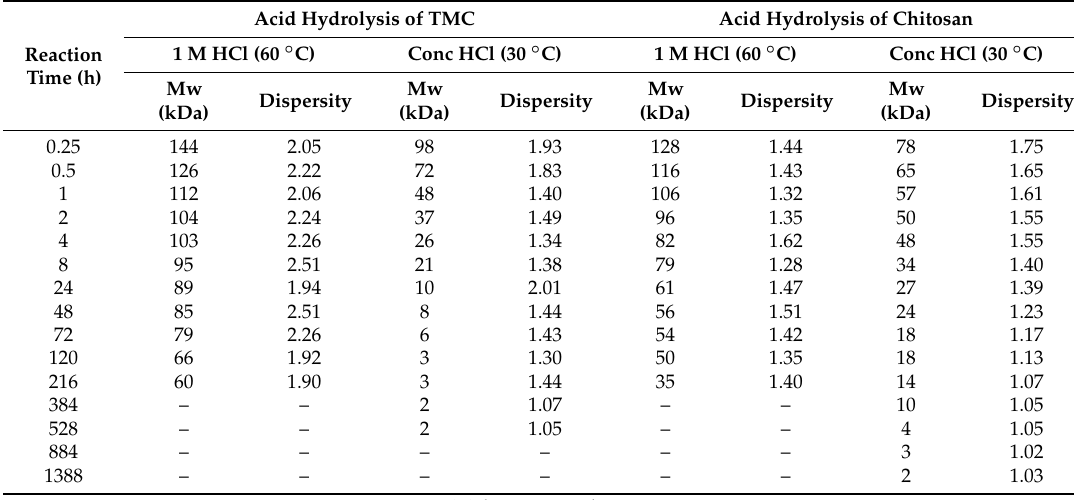
Table 1. Table showing the M w for the chitosan and TMC products obtained after different stages of